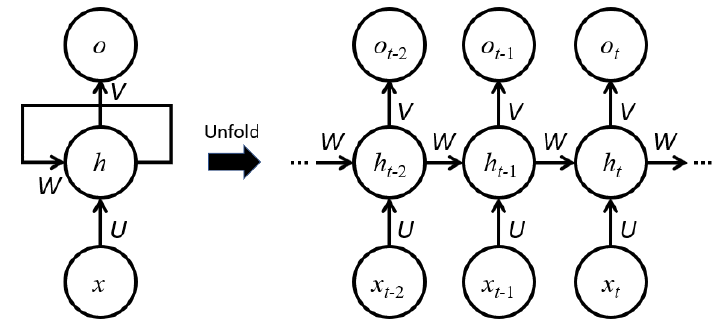
Figure 3. Structure of the recurrent neural network (RNN).